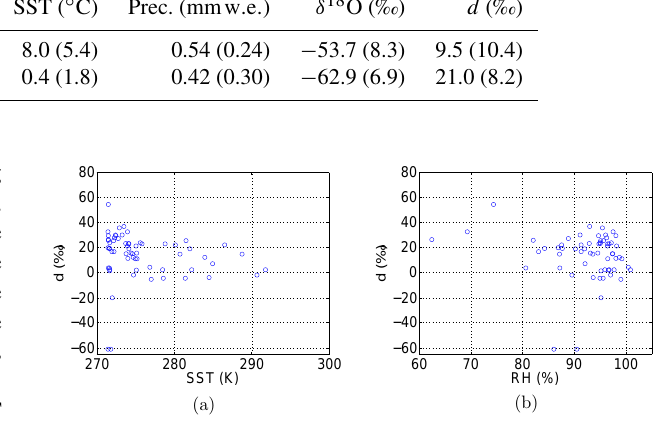
Figure 15. Measured deuterium excess plotted against areal mean of (a) SST and (b) RH calculated at SST from ERA-interim in the estimated source regions for days with trajectories